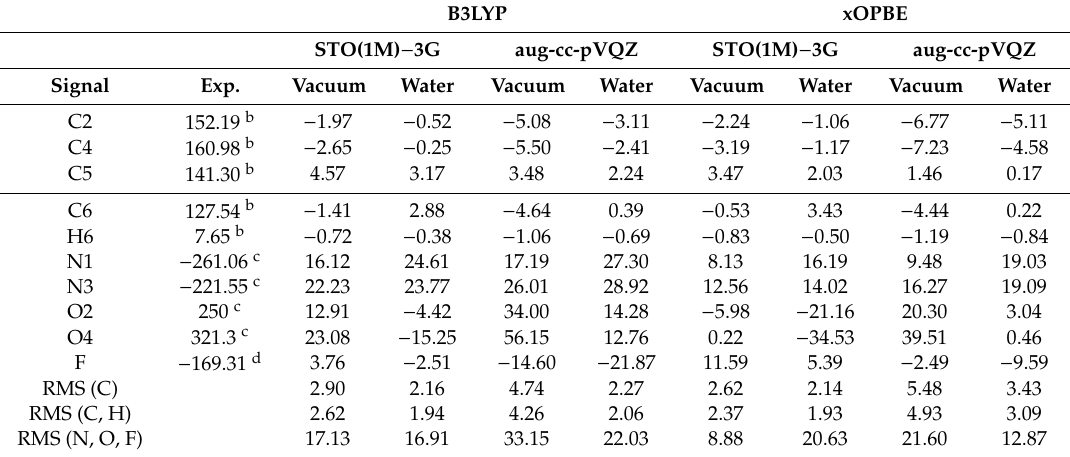
Table 4. Deviations from experiment of B3LYP and xOPBE calculated chemical shifts (in ppm) with STO(1M) − 3G. aug-cc-pVQZ basis sets for 5FU tautomer 1 in the gas phase and water a . Separate RMS values for selected nuclei are